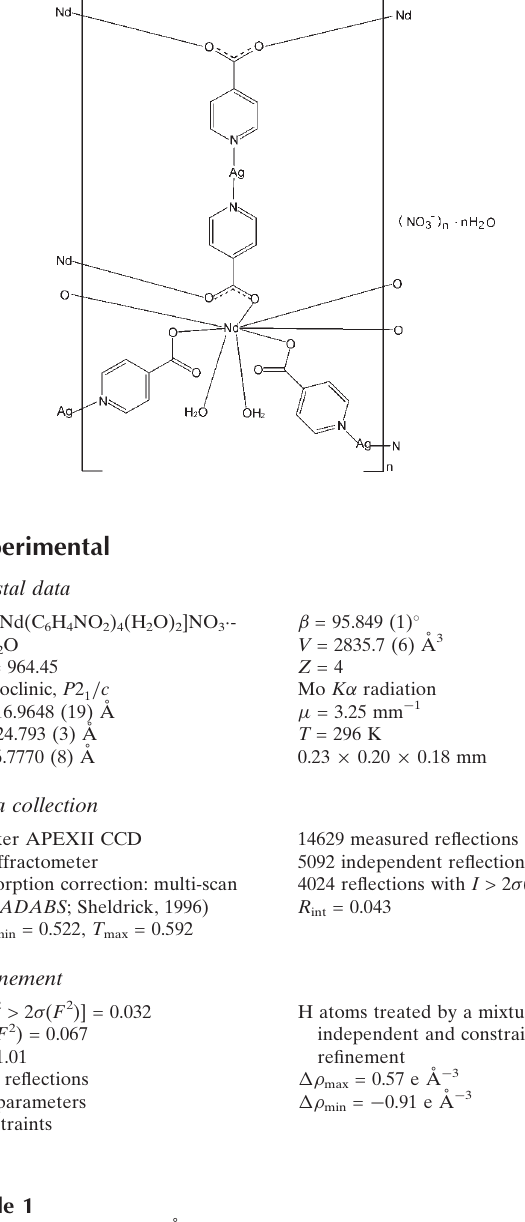
Selected bond lengths (A˚